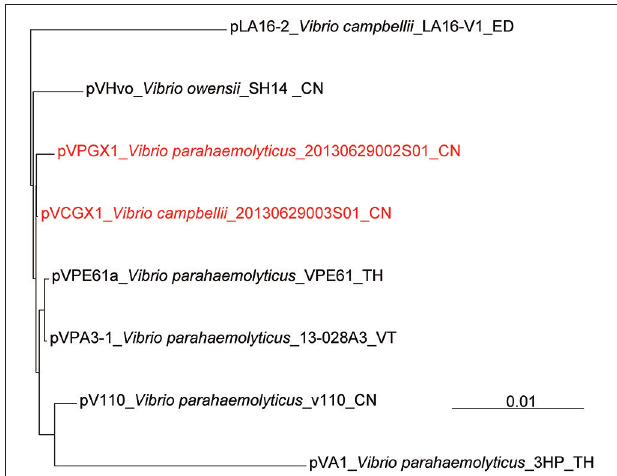
FIGURE 3 | Phylogenetic reconstruction based on complete sequences of pirAB vp -bearing plasmids. The complete reference sequences